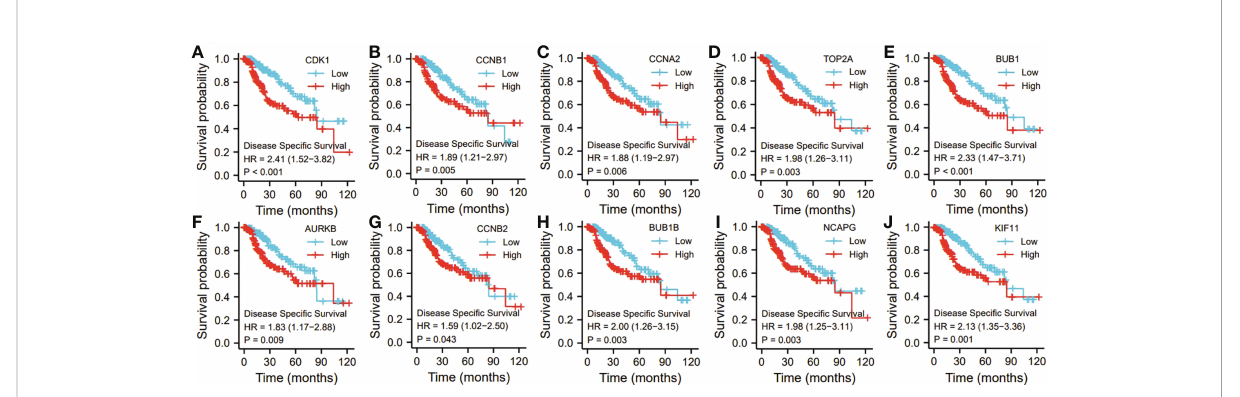
FIGURE 11 The hub gene related to the disease speci fi c survival (DSF) of HCC patients in TGCA database. The expressions of CDK1 (A) . CCNB1 (B) , CCAN2 (C) . TOP2A (D) , BUB1 (E) , AURKB (F) , CCNB2 (G) , BUBIB (H) , NCAPG (I) , and KIF11 (J) were shown.